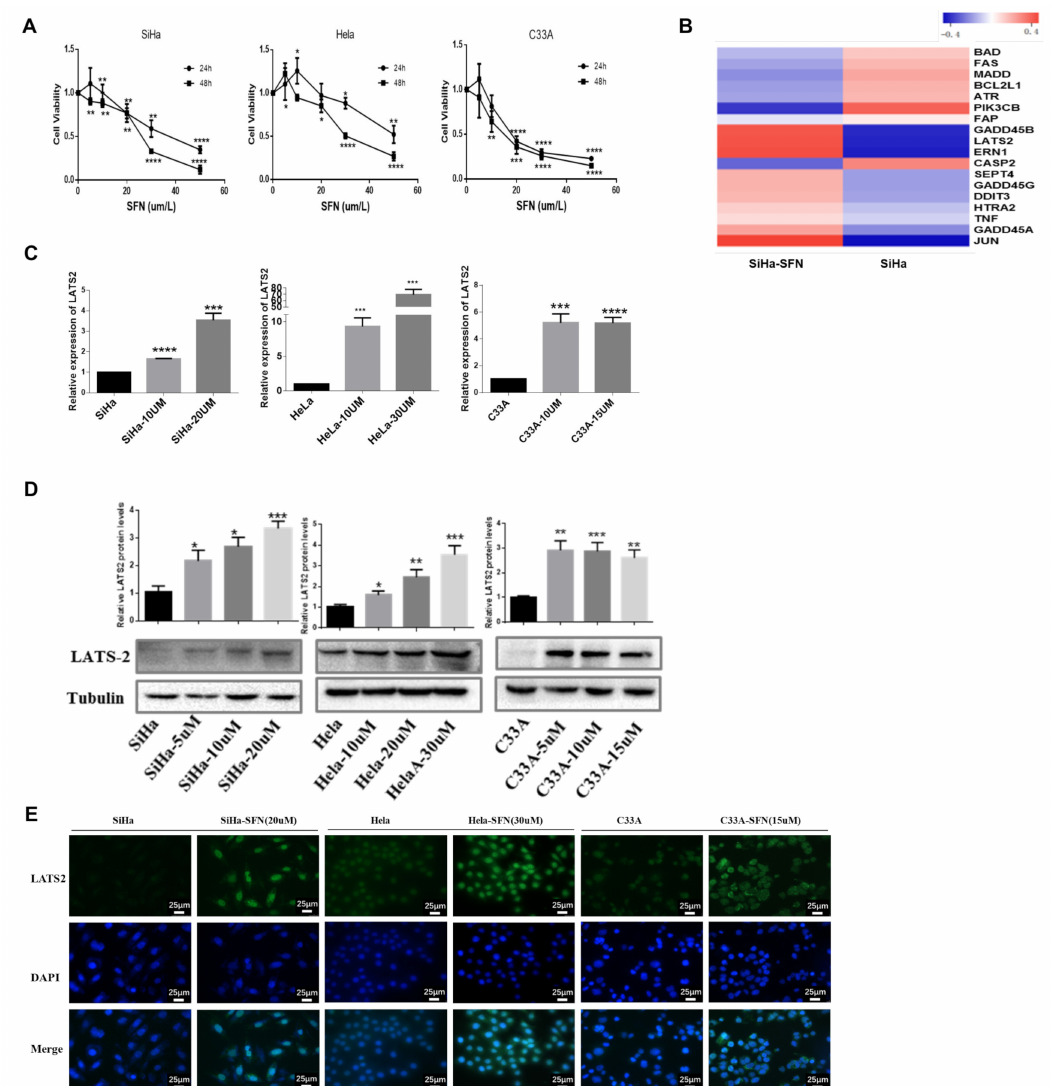
Figure 1. SFN inhibits cell proliferation and promotes LATS2 expression. ( A ) SiHa, HeLa, and C33A cells were treated with accelerating concentrations of SFN, from 5 µ M to 50 µ M. Cell viability was evaluated by CCK8 assay at 24 h and 48 h. ( B ) RNA-Seq analysis of SiHa cells comparing genes expression involving cycle arrest and apoptotic functions between SFN treatment (25 µ M) and the blank. ( C , D ) LATS2 mRNA and protein level were investigated after 48 h of SFN treatment with RT-PCR and Western blotting. Tubulin was used as a loading control. Cropped blots were showed in Western blotting. The samples derived from the same experiment and those blots were processed in parallel. ( E ) LATS2 was examined by the immunofluorescence in SiHa, C33A, and HeLa cells after treatment of SFN for 48 h. * p < 0.05, ** p < 0.01, *** p < 0.001, **** p <